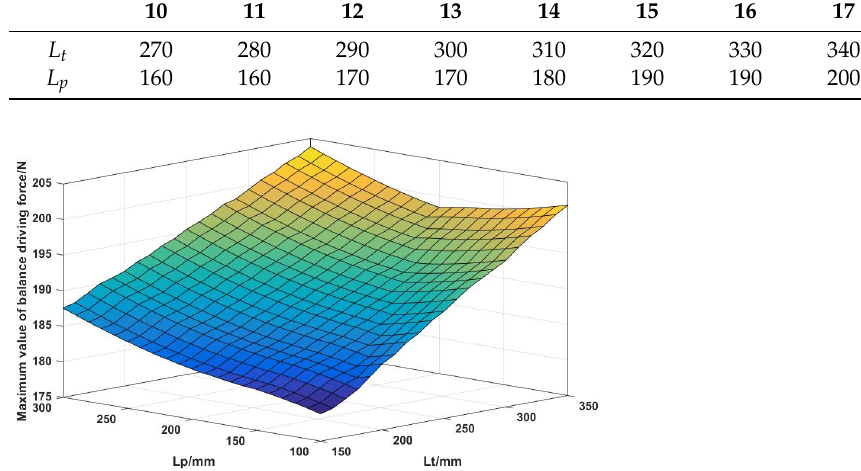
Figure 9. The relationship between the maximum value of balance driving force and the size.